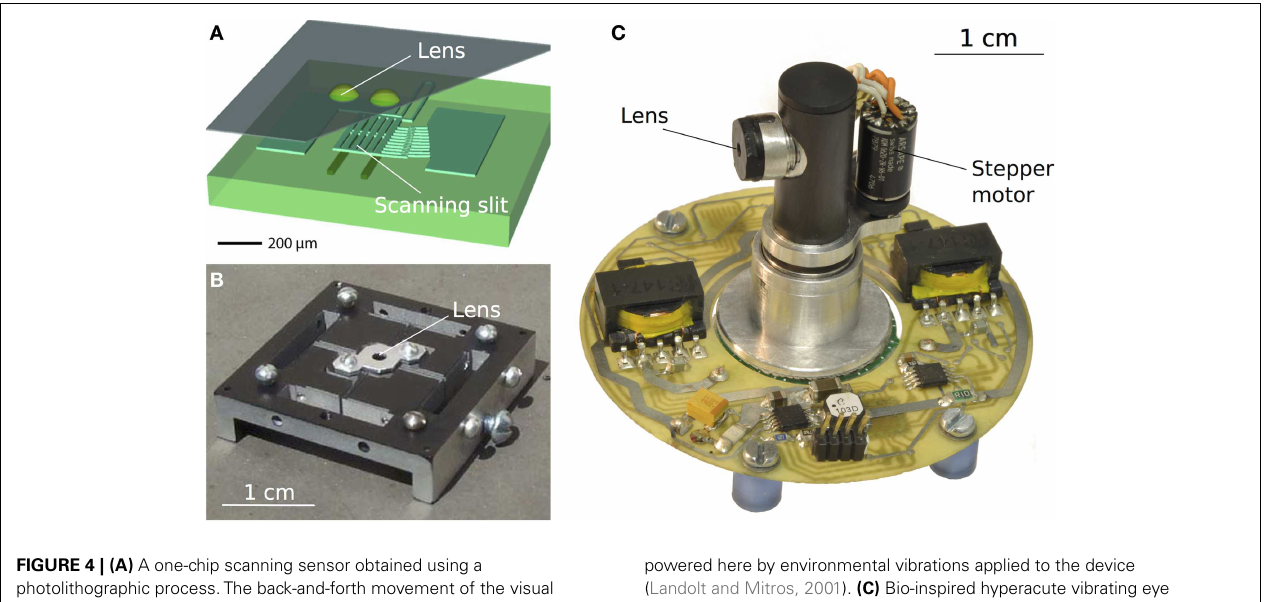
FIGURE 4 | (A) A one-chip scanning sensor obtained using a photolithographic process.The back-and-forth movement of the visual axes was implemented here via an electrostatically driven scanning slit placed over the photodiodes [reproduced with permission from Hoshino et al. (2001)]. (B) A visual scanning sensor inspired by the spiders retinal movements.The passive scanning movements were